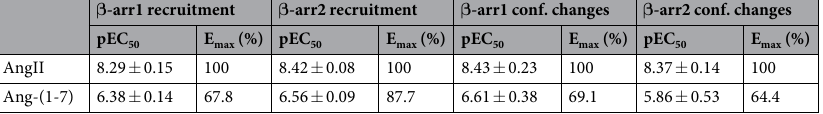
± SEM of at least three 50 values are presented as mean